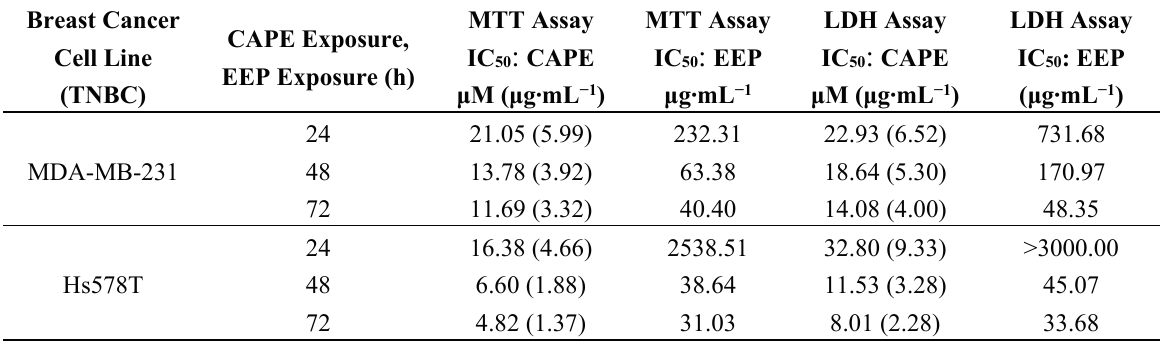
Table 2. Comparison of IC 50 values for MDA-MB-231 and Hs578T cells obtained from the LDH leakage assay and MTT assay following exposure to CAPE and EEP for 24, 48 and 72 h. Breast